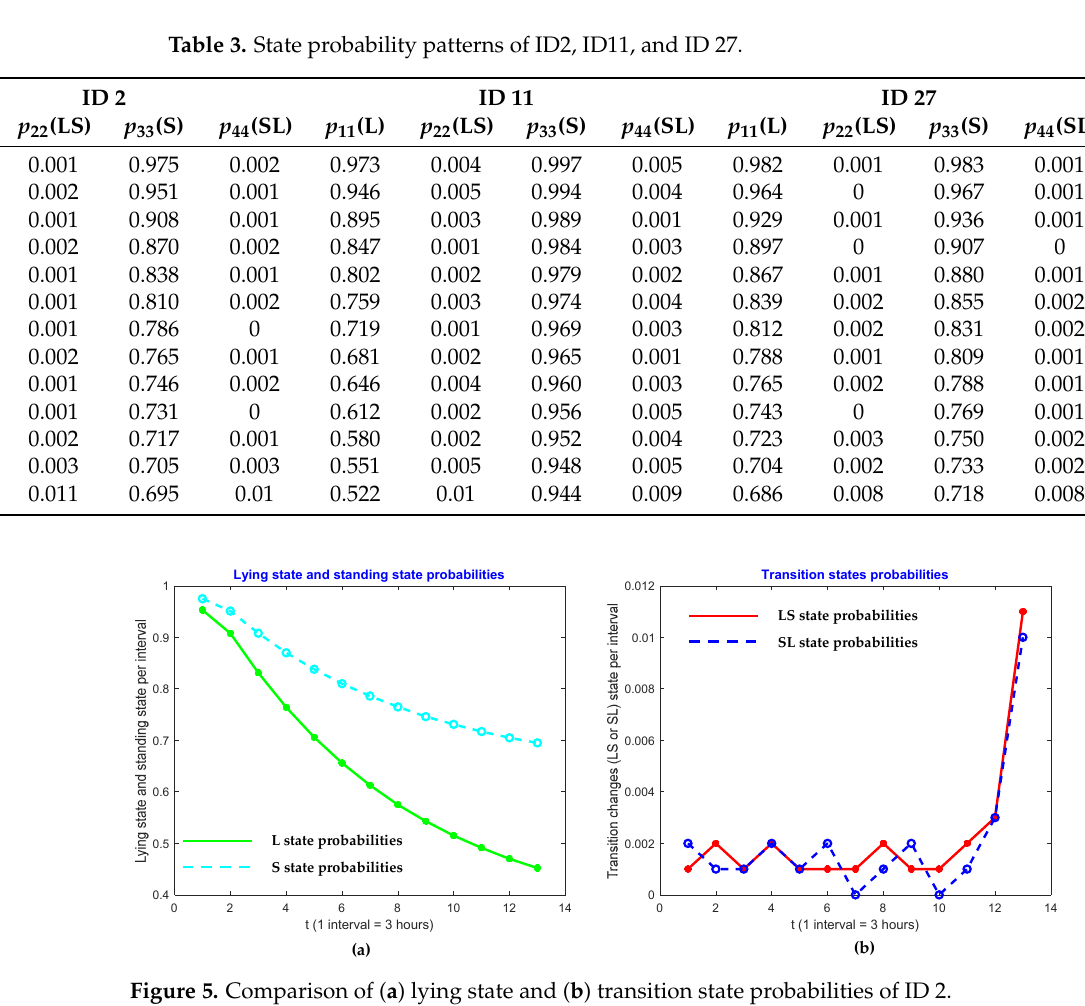
Figure 5. Comparison of ( a ) lying state and ( b ) transition state probabilities of ID 2.